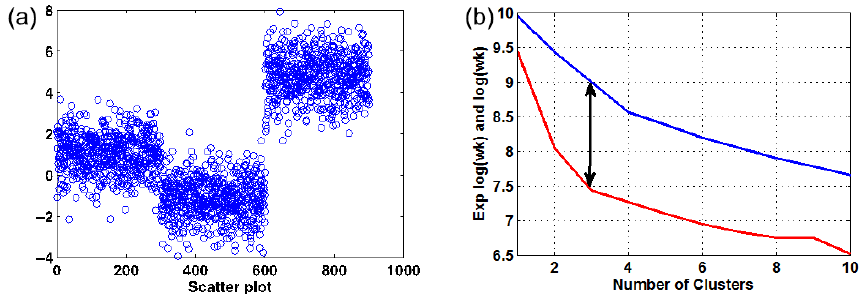
Figure 4. Results of the example with three clusters: (a) sensor nodes; (b) weight dispersion, W k , as a function of k number of clusters.